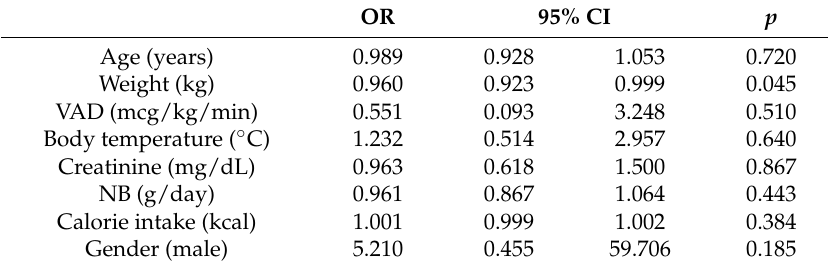
Table 4. Multivariate analysis of variables associated with hypometabolism in severe AKI patients.